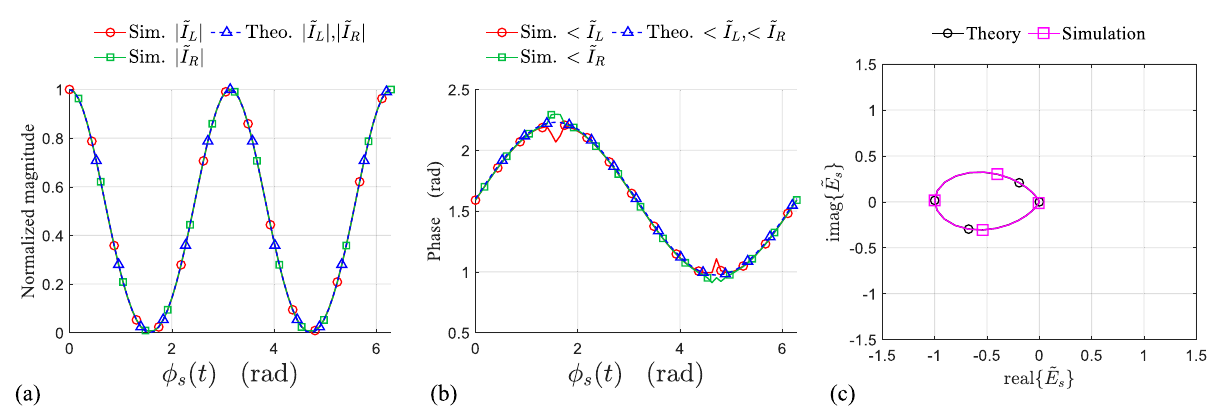
Figure 5. ( a ) Normalized magnitude, ( b ) phase of the induced currents on the left and right side of the non-symmetrically rotating rectangular loop during one period of rotation, obtained from the model and simulations. ( c ) IQ constellation of the time-varying complex envelope of the normalized backscattered field from non-symmetrically rotating loop in simulation and